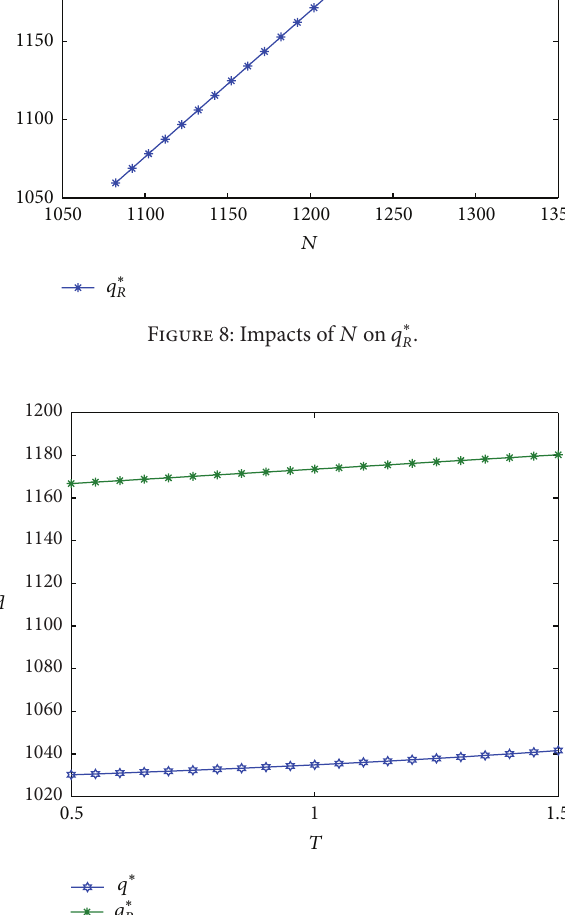
Figure 8: Impacts of 𝑁 on 𝑞 ∗ 𝑅 .